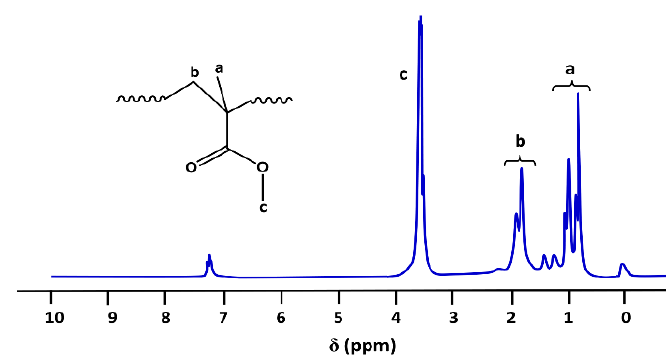
Figure 1. 1 HNMR spectrum of PMMA obtained in CDCl 3.